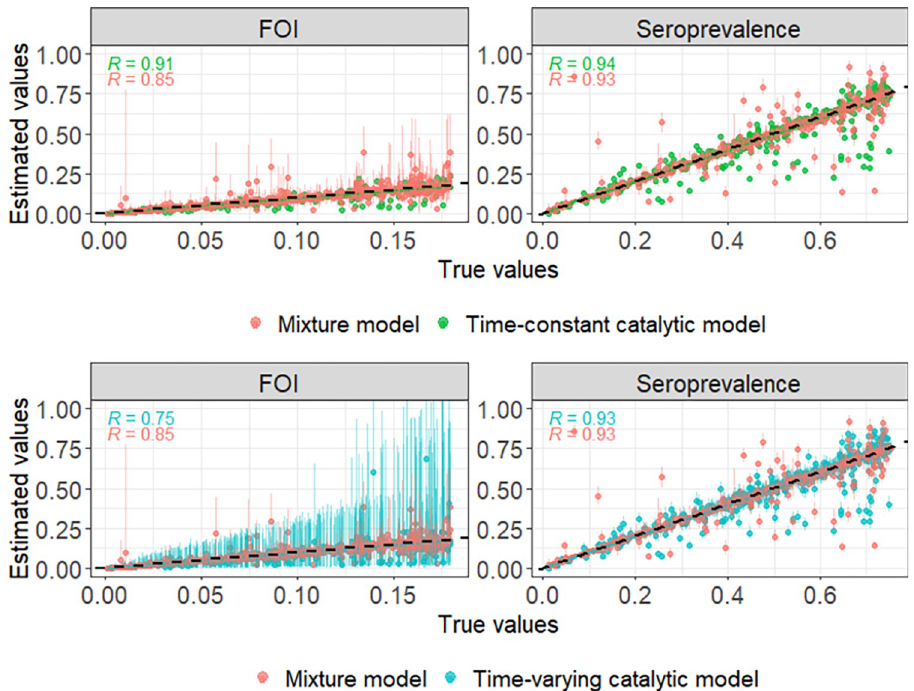
Fig 2. True versus estimated seroprevalence and force of infection (FOI) values from the mixture and catalytic models fitted to the simulated datasets (Dataset C). The catalytic model was run under the assumption that the FOI was time-constant or time-varying. The 95% Confidence Intervals for the estimated values were calculated using a bootstrap method and are shown here as error bars; the point denotes the central estimate. The Pearson’s correlation coefficients ( R ) are shown. The dashed line represents the line y = x and shows where points would be located in a scenario with zero bias in the estimated values.